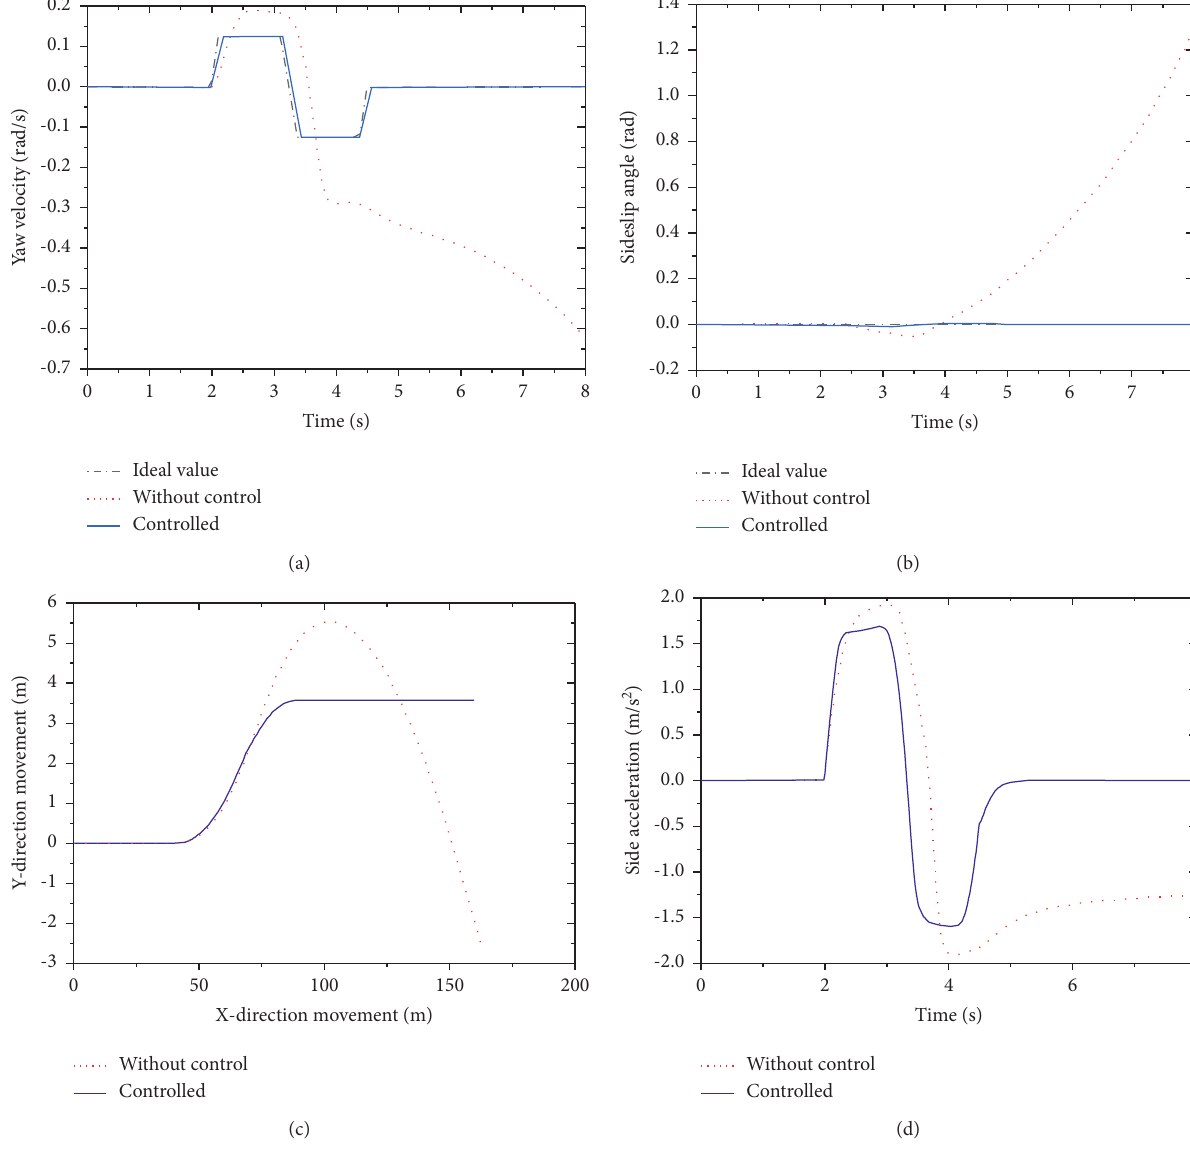
Figure 9: Simulation results of single lane change with adhesion coefficient of 0.2 and initial velocity of 50km/h. (a) Change in yaw velocity. (b) Changes in sideslip angle. (c) Vehicle trajectory. (d) Change in lateral acceleration.